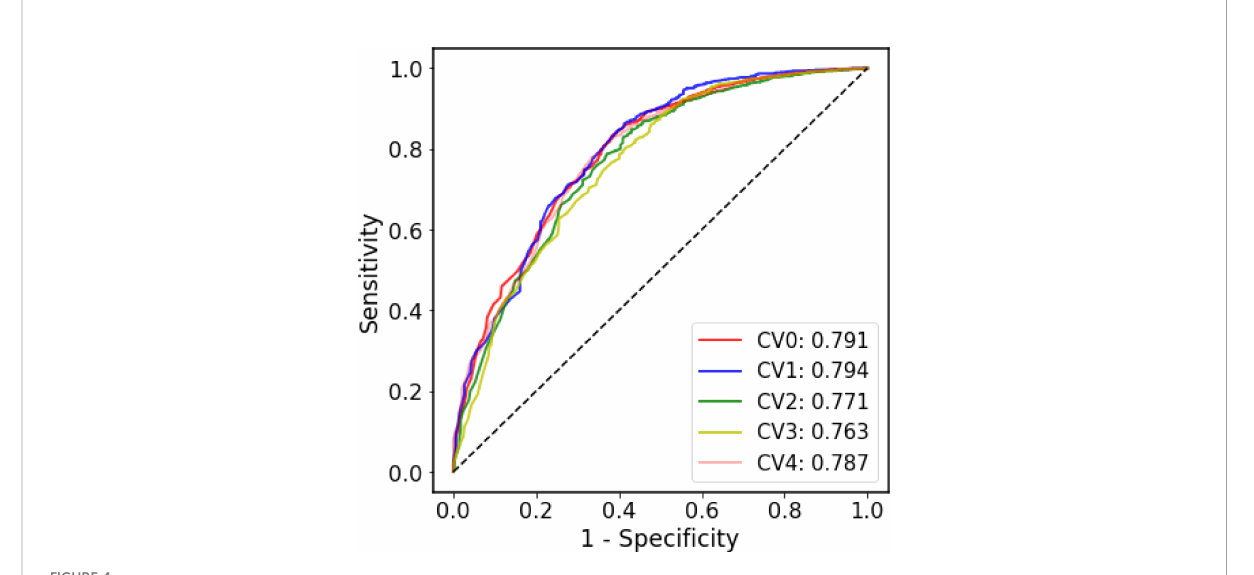
FIGURE 4 The ROC curves of the fi ve-fold cross-validation on the SARS-CoV